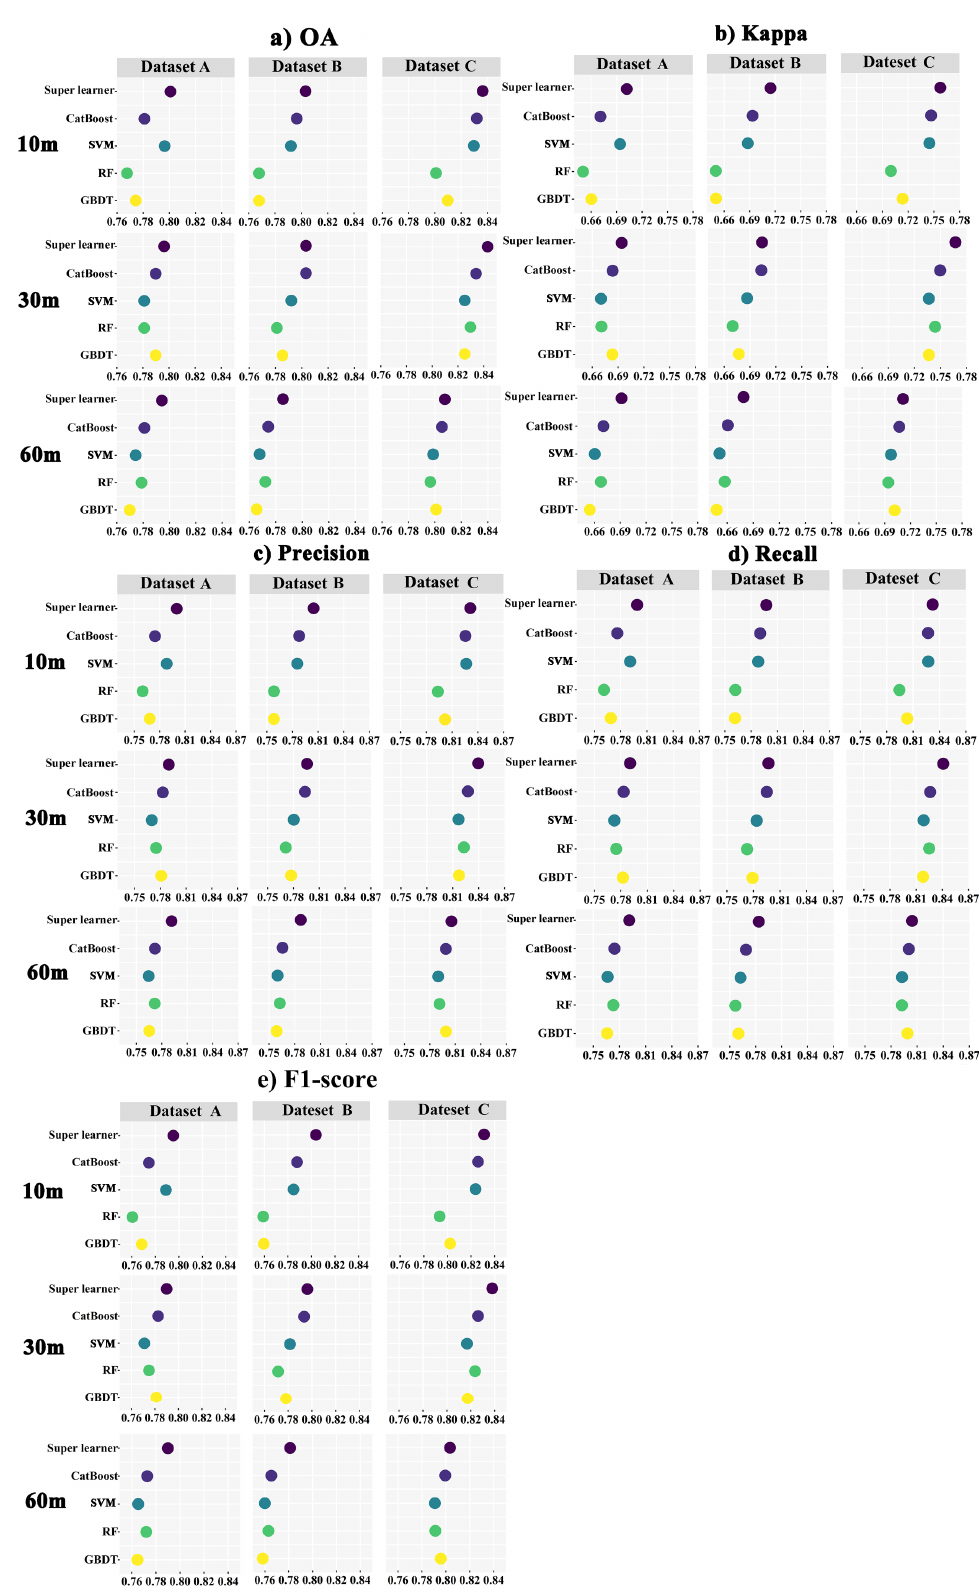
Figure 6. Model accuracy plots based on ( a ) overall accuracy (OA); ( b ) Kappa; ( c ) Precision; ( d ) Recall; and ( e ) F1-score (Dataset A: purely remote sensing variables from Landsat-8 data. Dataset B: purely remote sensing variables from Sentinel-2 data without red-edge factors. Dataset C: purely remote sensing variables from Sentinel-2 data with red-edge factors).